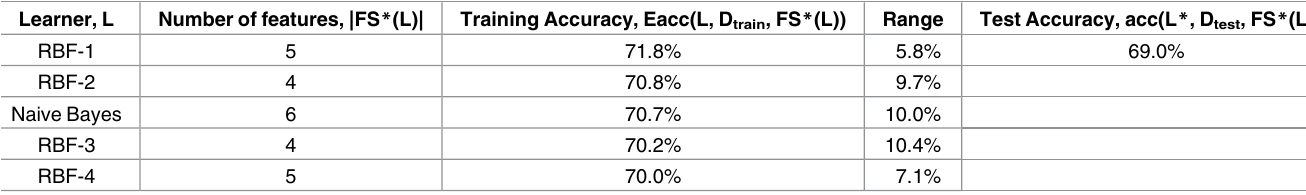
Table 9. ADHD-200,personal characteristic